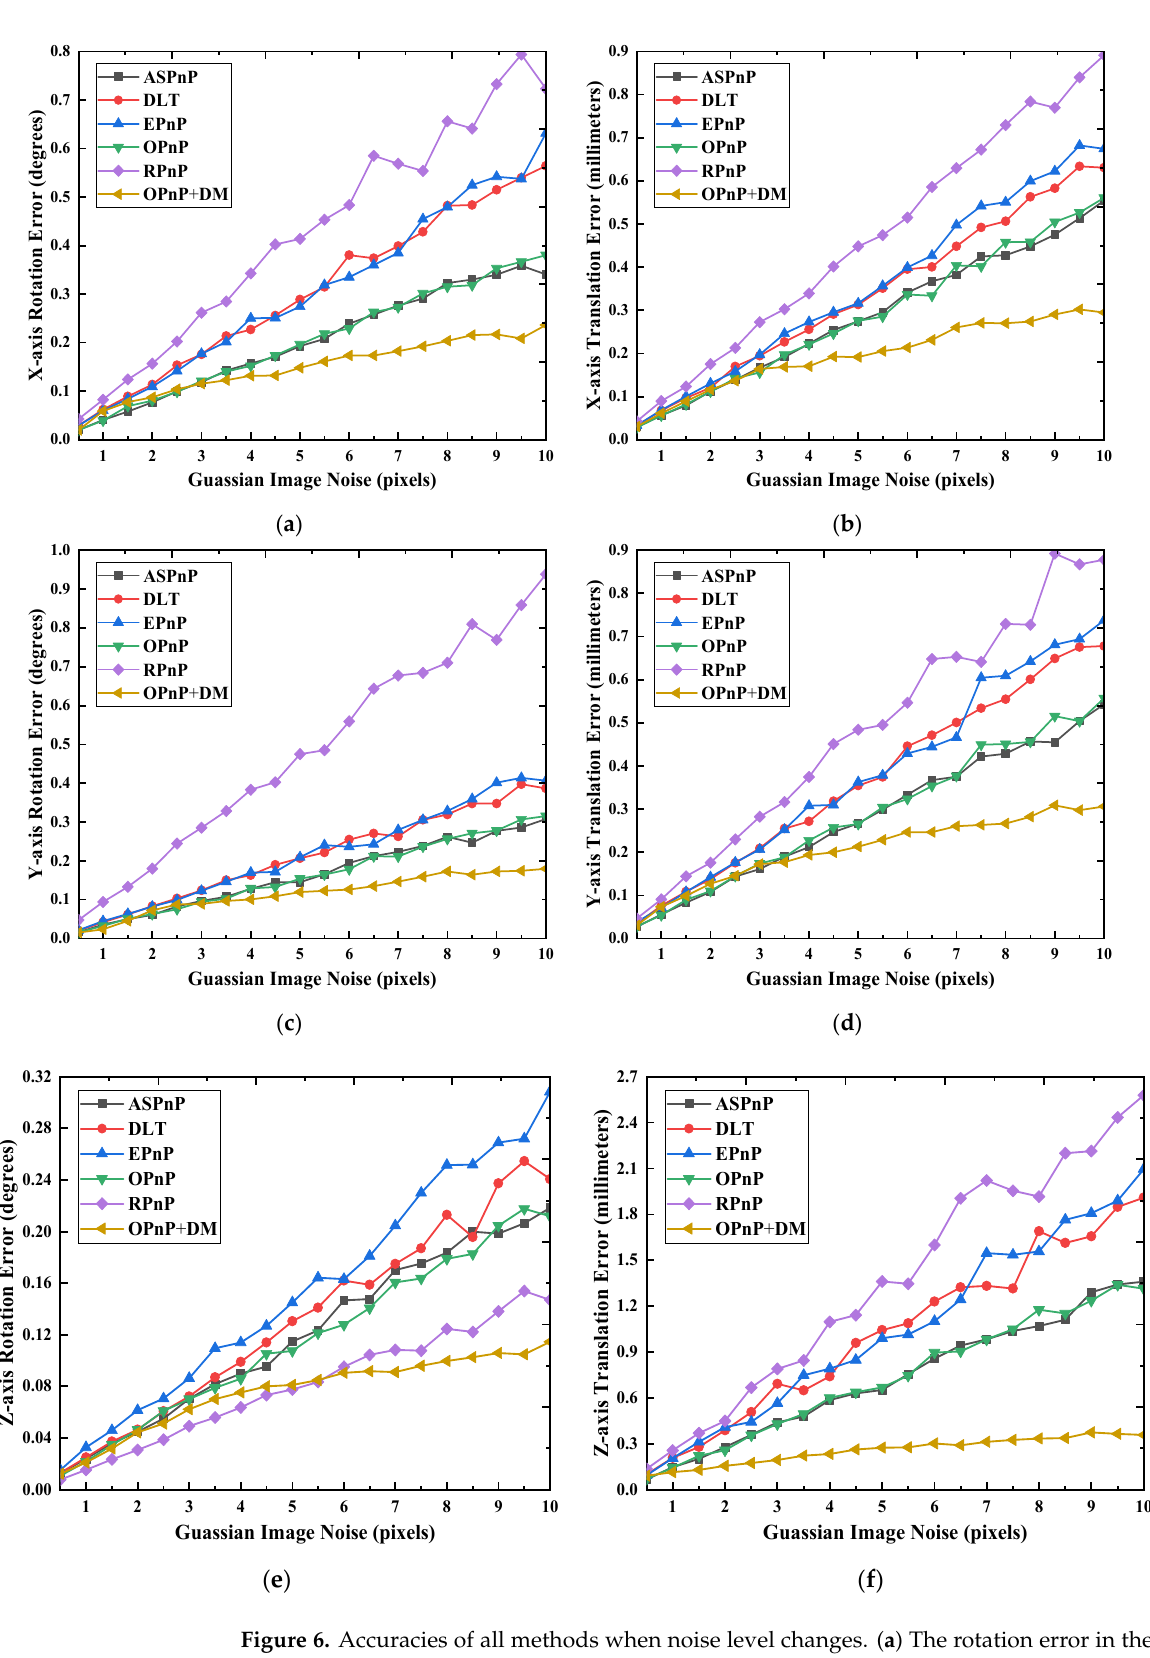
Figure 6. Accuracies of all methods when noise level changes. ( a ) The rotation error in the X -axis direction; ( b ) The movement error in the X -axis direction; ( c ) The rotation error in the Y -axis direction; ( d ) The movement error in the Y -axis direction; ( e ) The rotation error in the Z -axis direction; ( f ) The movement error in the Z -axis direction.